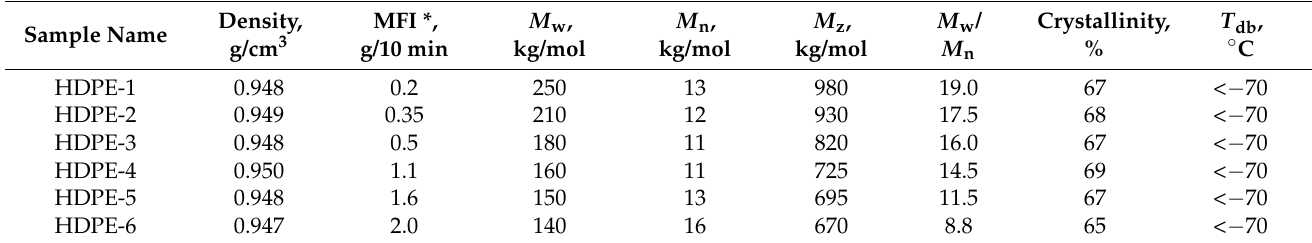
Table 4. The results of analyzing the HDPE samples